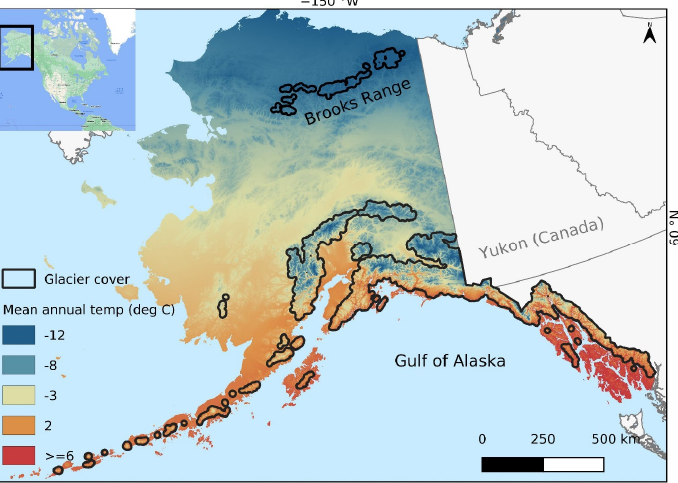
Figure 1. Climate normal (1981–2010) calculated from mean annual temperature from Daymet v4 [36], including simplified outlines of glacier-covered areas within Alaska.